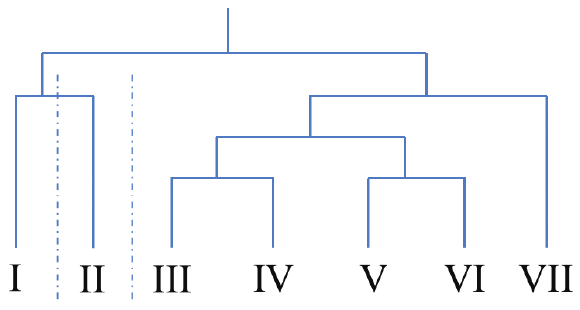
Figure 4. Dendrogram showing the TWINSPAN classifi- cation of the seven